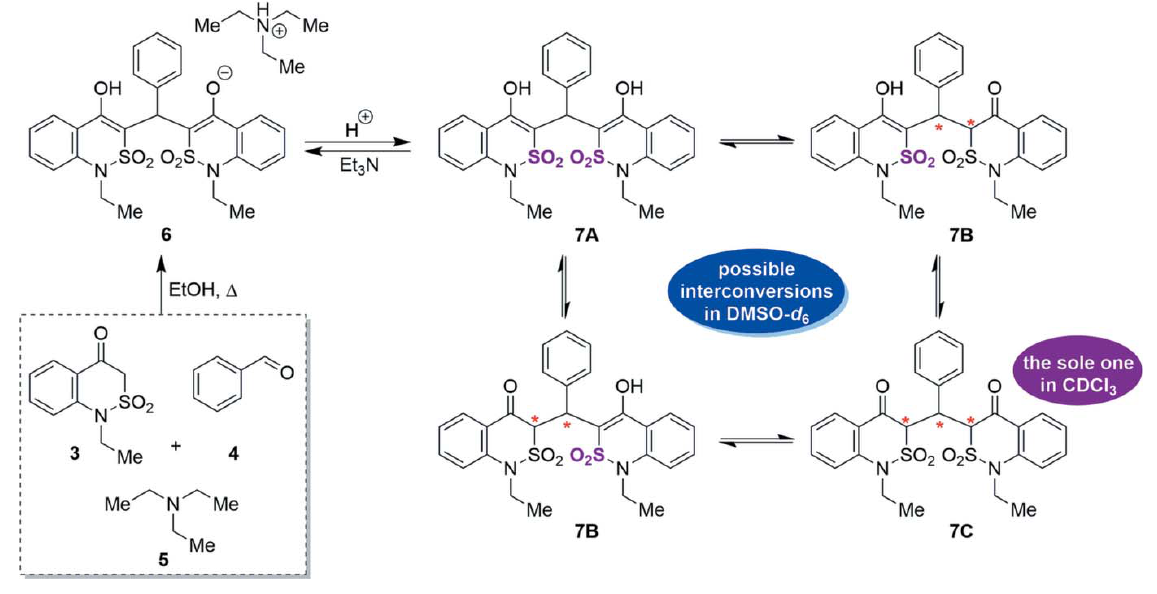
Figure 2 Preparation of triethylammonium salt 6 , its hydrolysis and possible tautomeric interconversions of product 7 formed (chiral carbon atoms are starred).